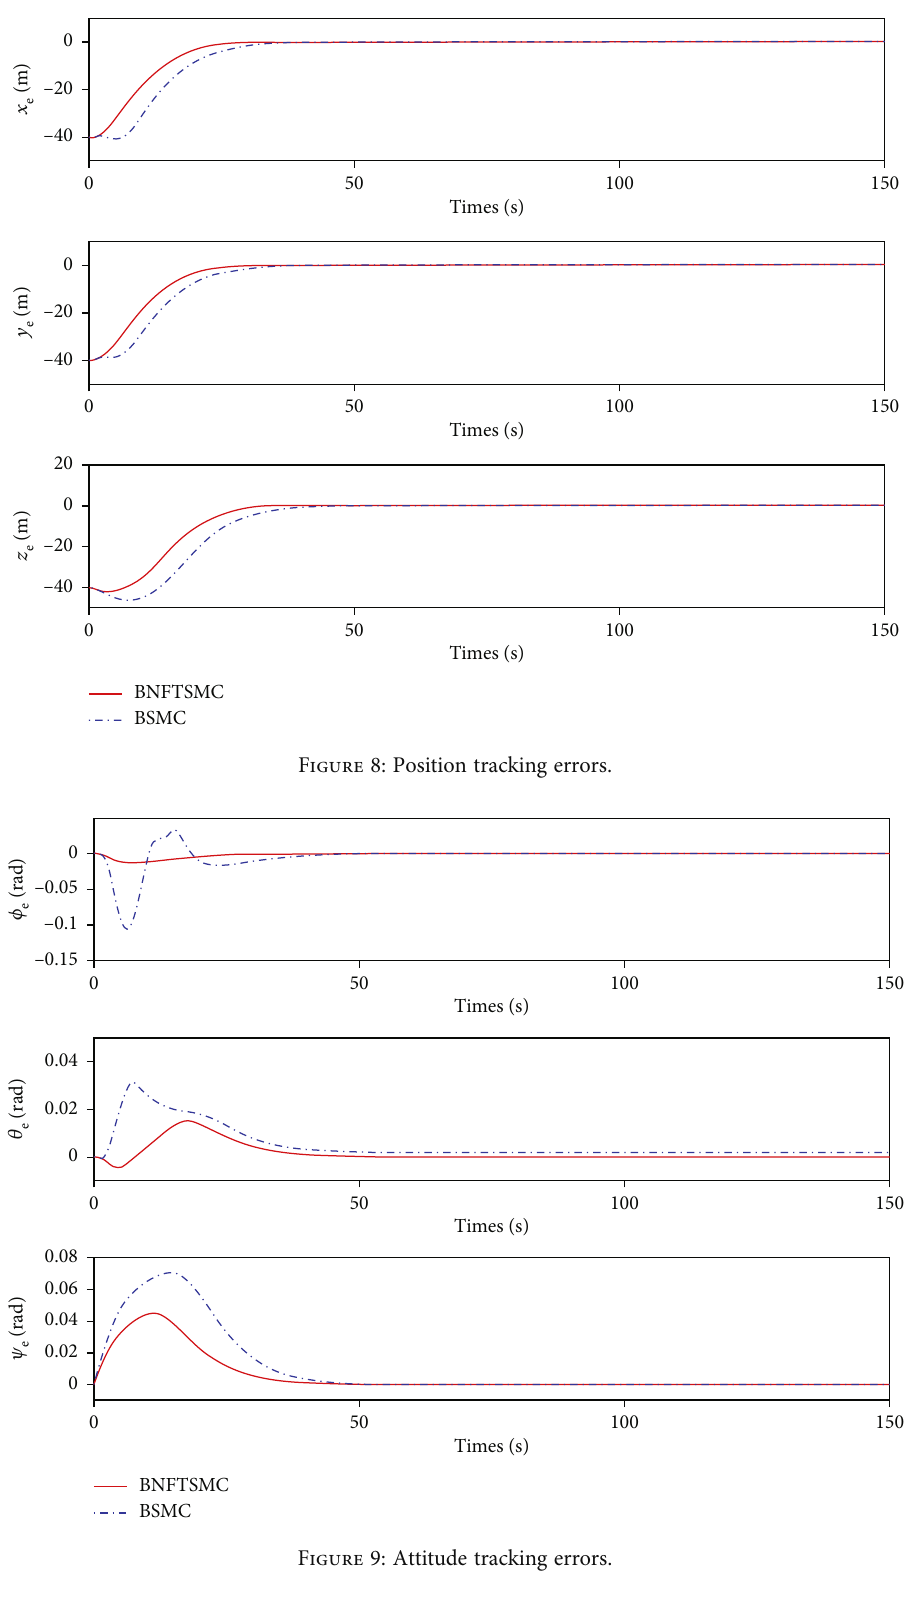
Figure 9: Attitude tracking